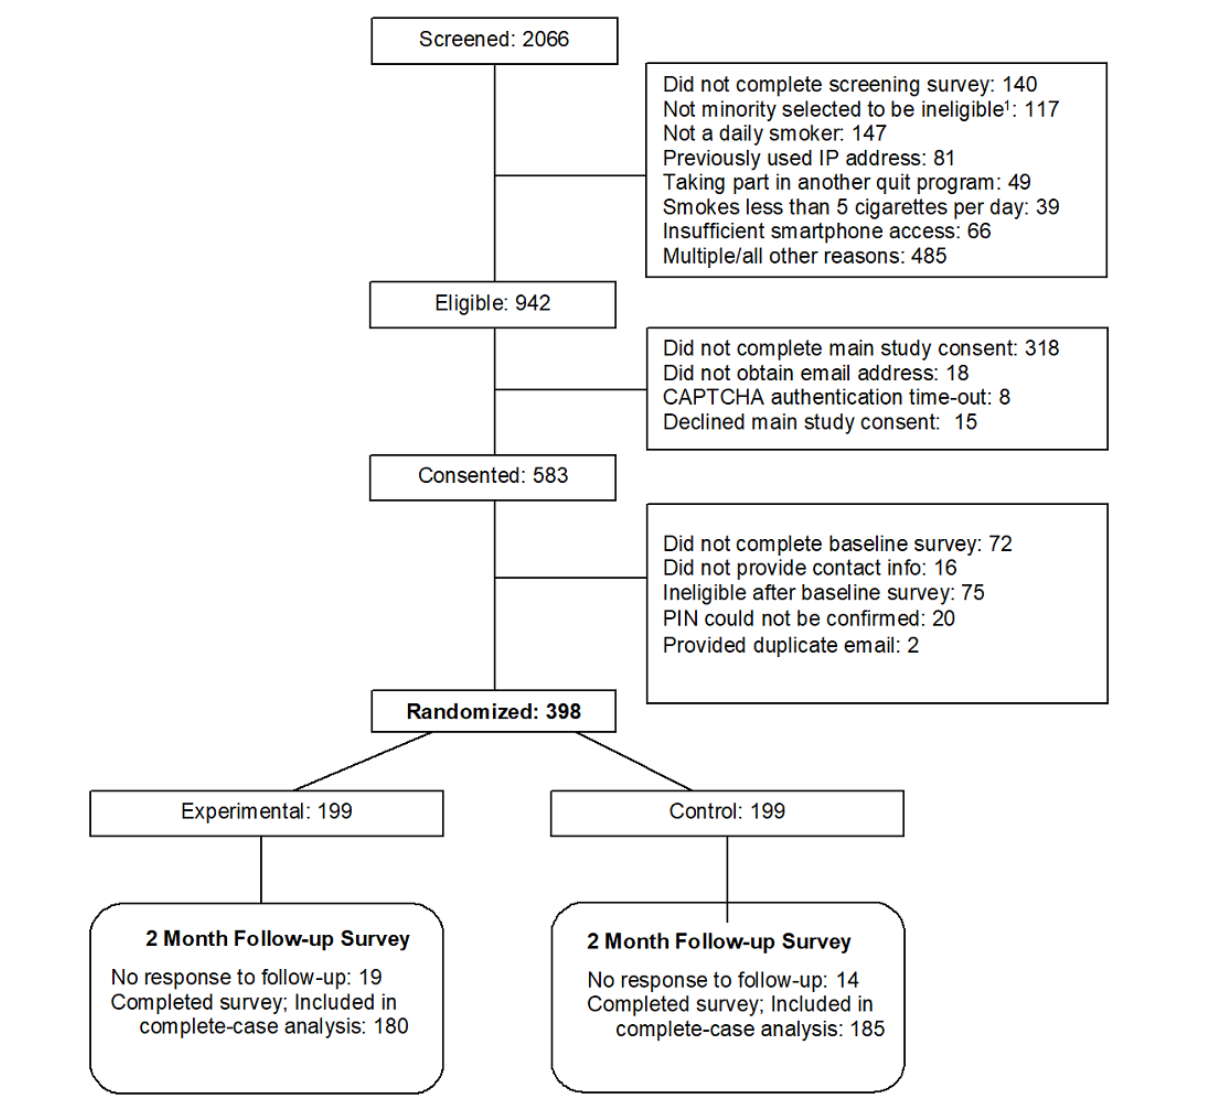
Figure 1. Participant flow diagram. To increase the enrollment of racial and ethnic minorities, some nonminorities who were otherwise eligible for study enrollment were randomly selected to be excluded. IP: Internet Protocol; PIN: personal identification